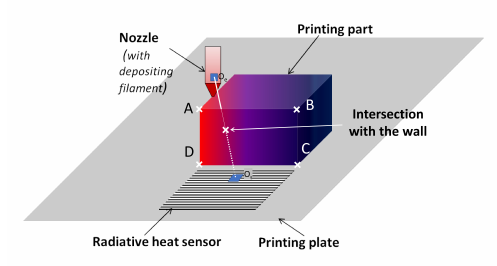
Figure 3. Radiative heat transfer